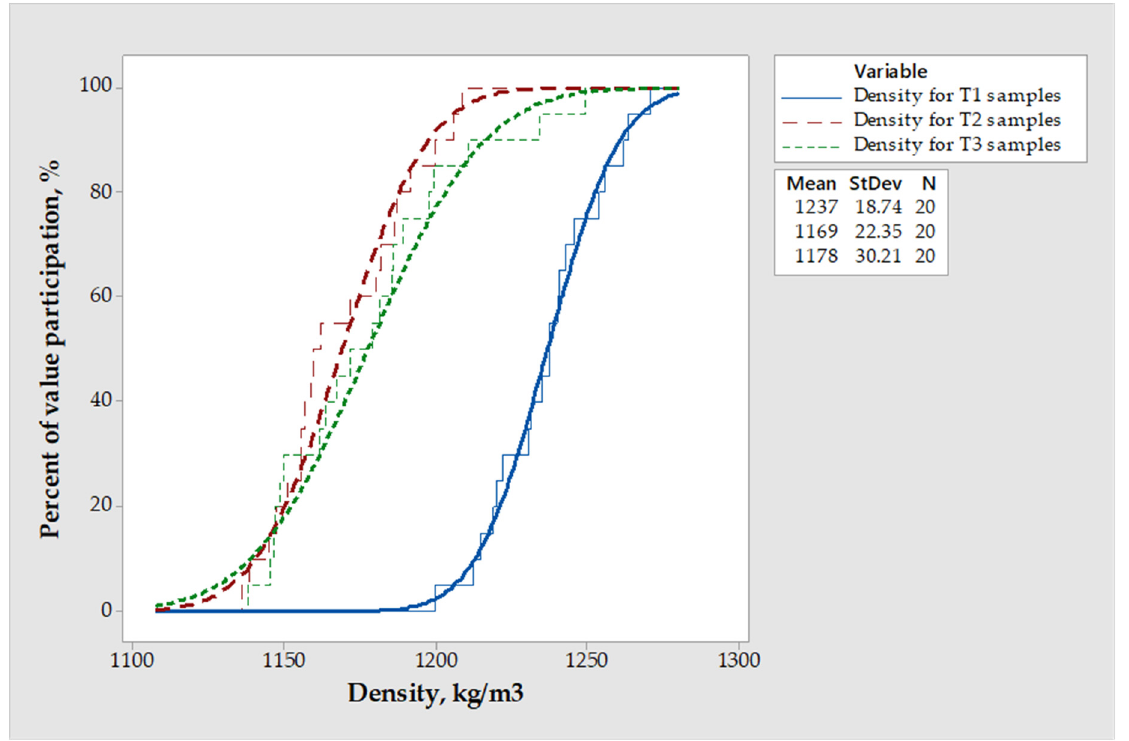
Figure 2. Empirical Cumulative Distribution Function (CDF) for the density of straw